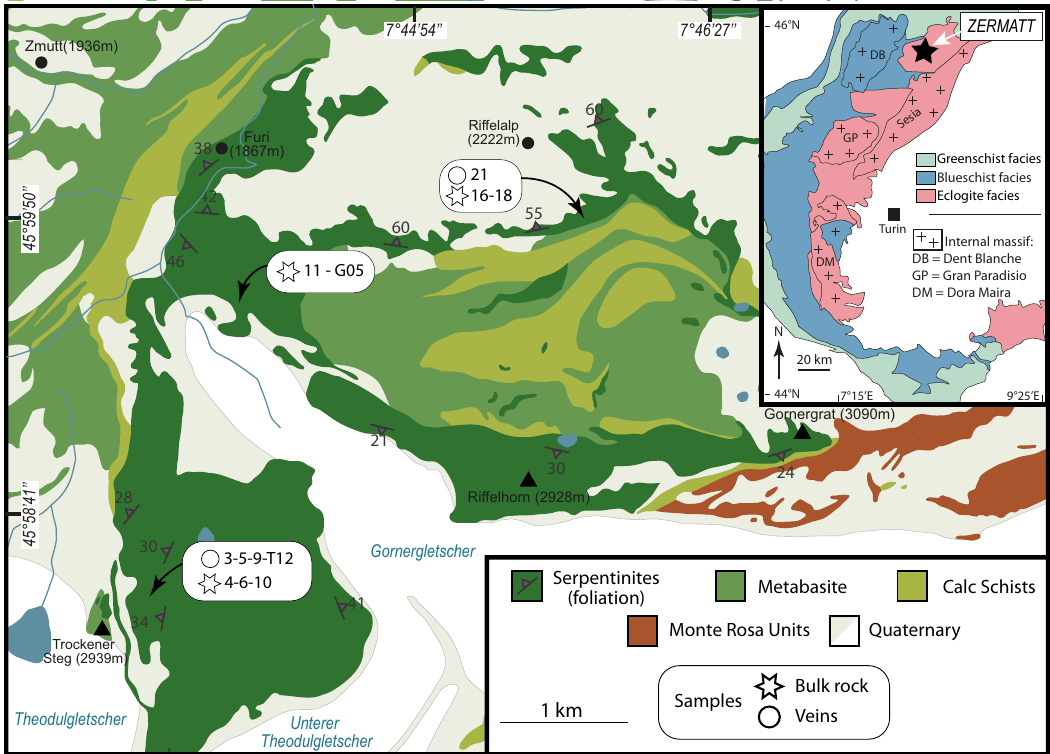
Fig. 1 Simpli fi ed geological map and sample localization in the investigated area of the Zermatt-Saas meta-ophiolite. Upper inset shows the Zermatt body in the frame of the alpine metamorphic